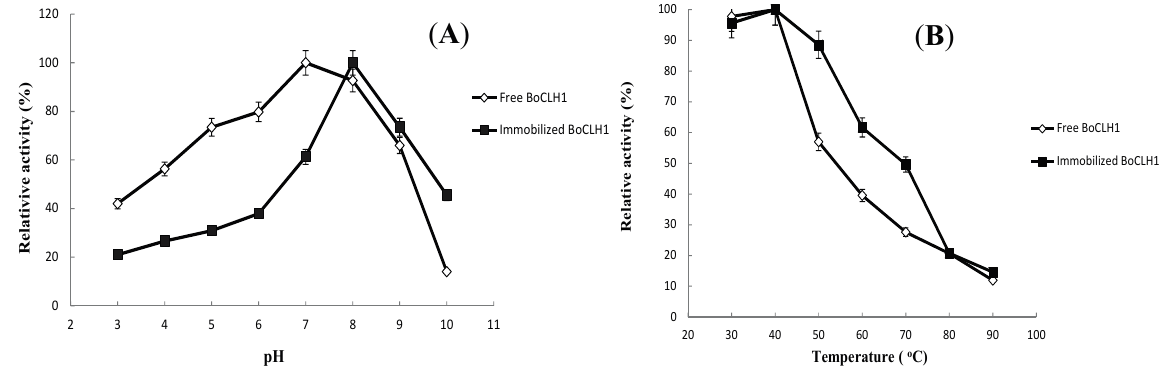
Figure 3. Effect of pH and temperature on the activity of free and immobilized BoCLH1. ( A ) Activity analysis of the free enzyme ( ◊ ) and the immobilized enzyme ( ■ ) were conducted at 40 °C and at pH 3 to 10 for 30 min. ( B ) Activity analysis of the free enzyme ( ◊ ) and the immobilized enzyme ( ■ ) were conducted at different temperatures (30–90 °C) for 30 min. A Cu(II)-loaded metal chelator was used for